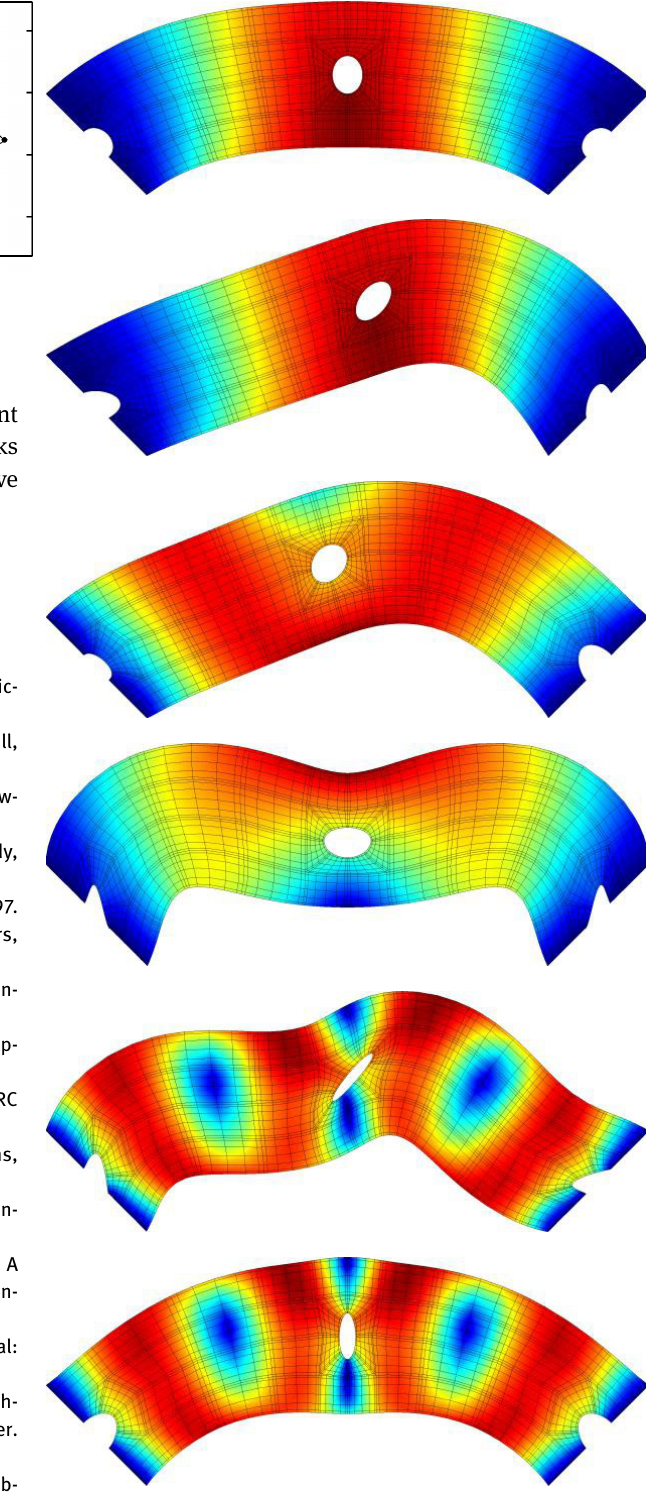
Figure 20: First six mode shapes of an isotropic arch using N = M = 7 grid per